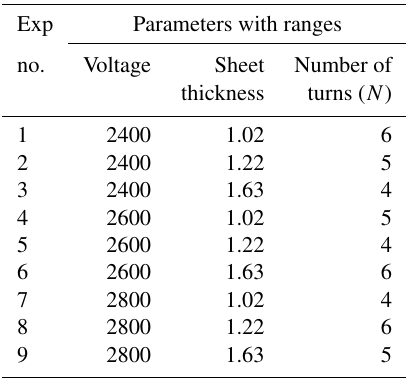
Table 2. Taguchi L9 array for electromagnetic forming of the Al 6061-T6